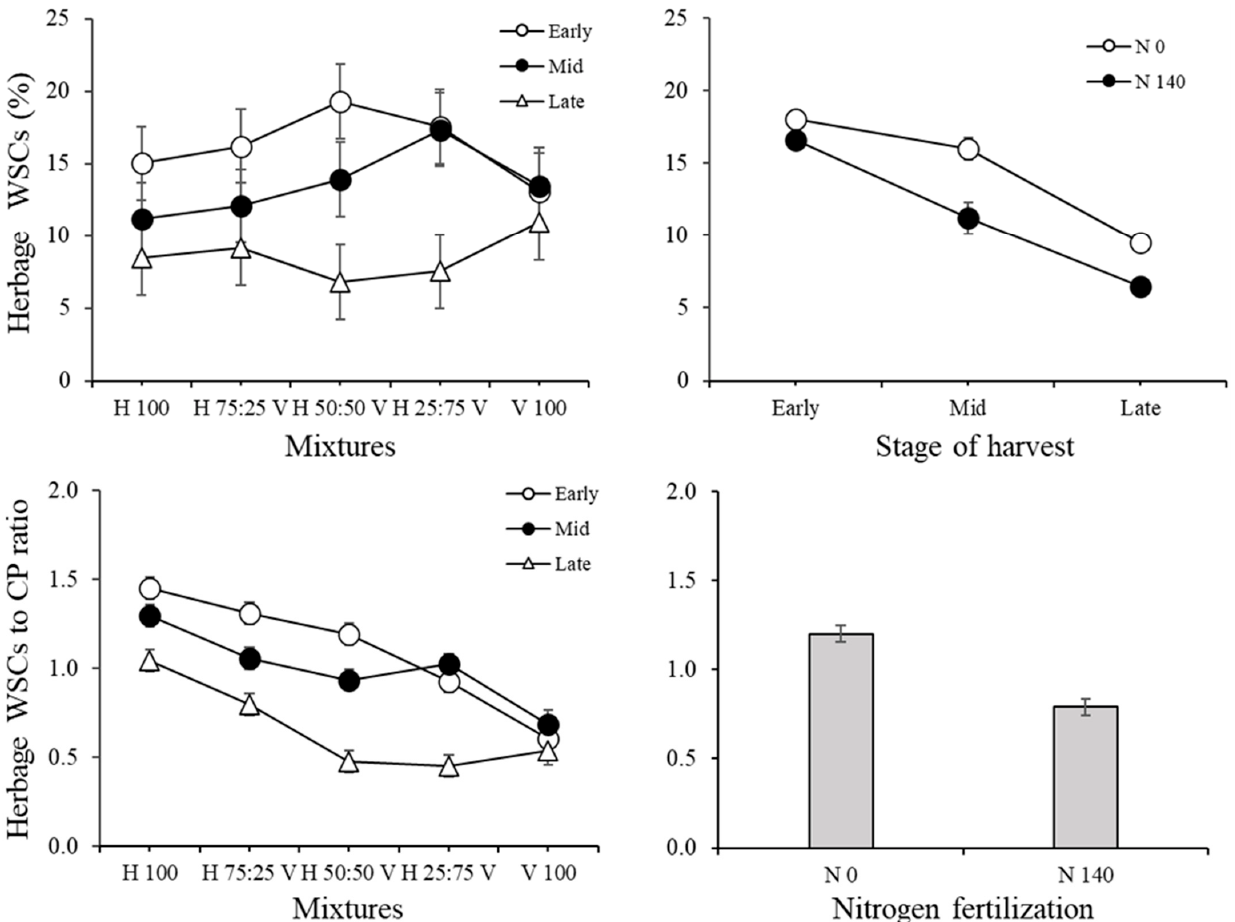
Figure 7. Herbage WSC concentration ( above ) as affected by SH × MX interaction ( left ) and SH × NF interaction ( right ). Herbage WSC to CP ratio ( below ) as affected by SH × MX interaction ( left ) and NF mean effect ( right ). On the left, values are LSmeans across all treatments along with standard error estimate of the LSmeans since the design was unbalanced between the faba bean crop ( n = 9) compared to the mixtures and the barley crops ( n = 18). On the right, only data of the barley-containing treatments were used. Each point represents the arithmetic mean ( n = 24) and its computed standard error.